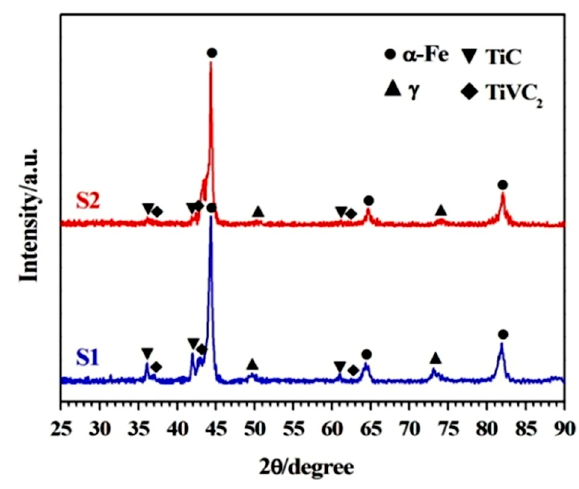
Figure 1. X-ray diffraction patterns of cladding layers.